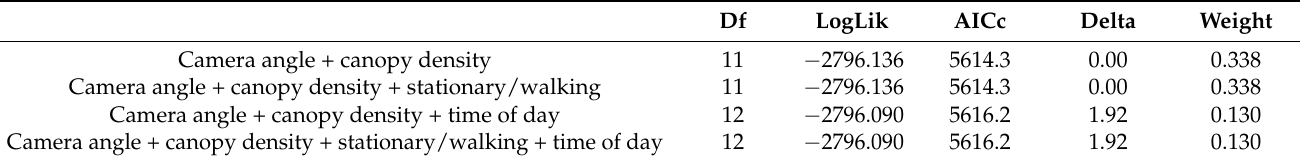
Table A5. The models with the best fit to the TIR data showing AICc and weight values.